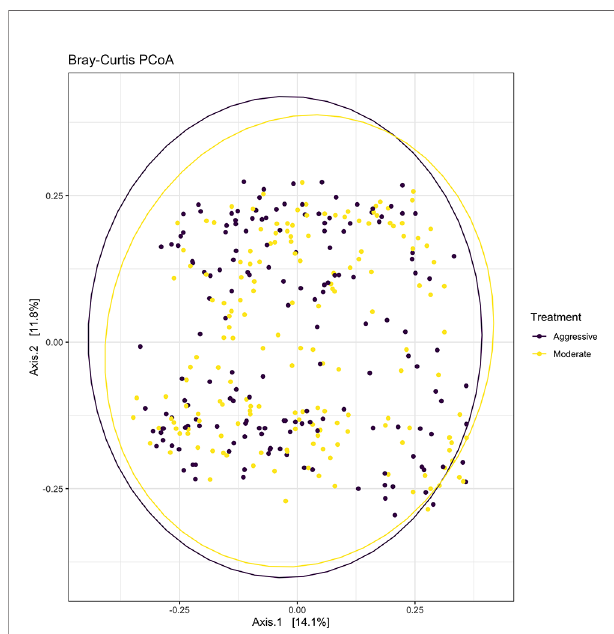
FIGURE 2 | Beta-diversity measurements for bacterial communities using Bray-Curtis distances to create a PCoA. Aggressive treatments are represented in purple and moderate treatments are represented in yellow. Ellipses represent 95% con fi dence intervals around means for aggressive and moderate implant strategies. Signi fi cant overlap between communities reveals no differences between moderate or aggressive treatments.